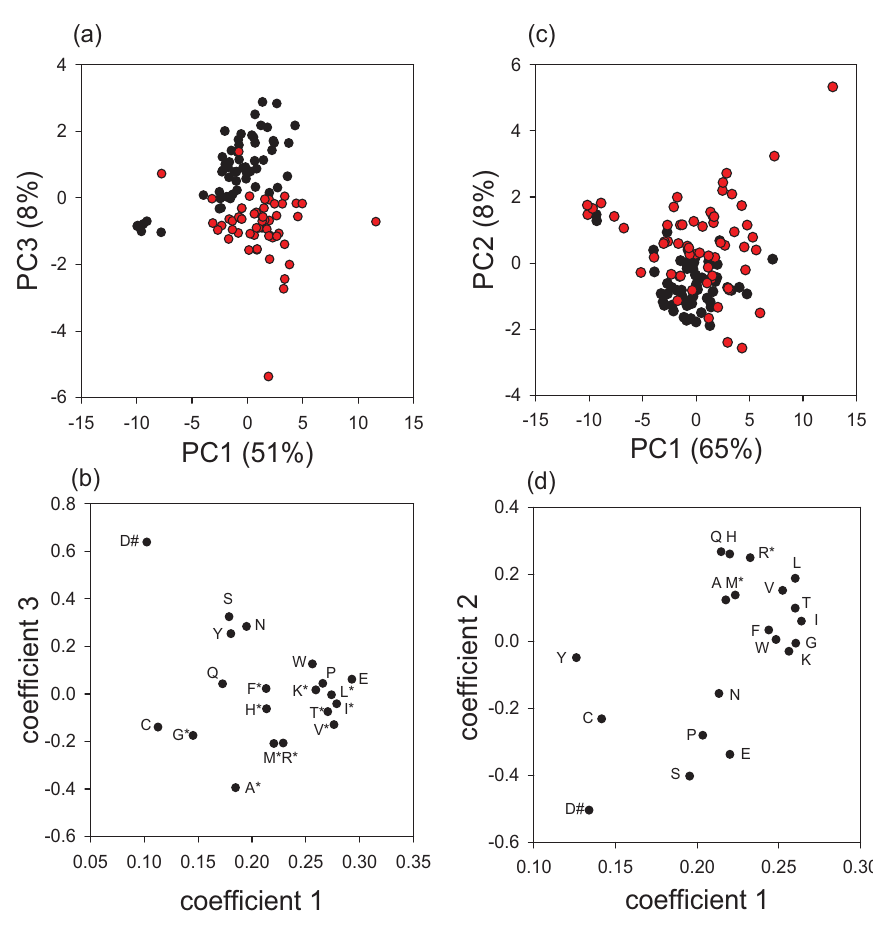
Figure 5. Principal components analysis of the free amino acid content of the honey bees (with open symbols uninfested and closed symbols Varroa -infested insects). Data for colonies with Varroa above the threshold for intervention are shown in red, and colonies below the threshold in black. ( a ) principal components 1 and 3 of pupae; ( b ) coefficients for pupae; ( c ) principal components 1 and 2 of newly-emerged bees; ( d ) coefficients for newly-emerged bees [#significantly elevated in uninfested insects; * significantly elevated in Varroa -infested